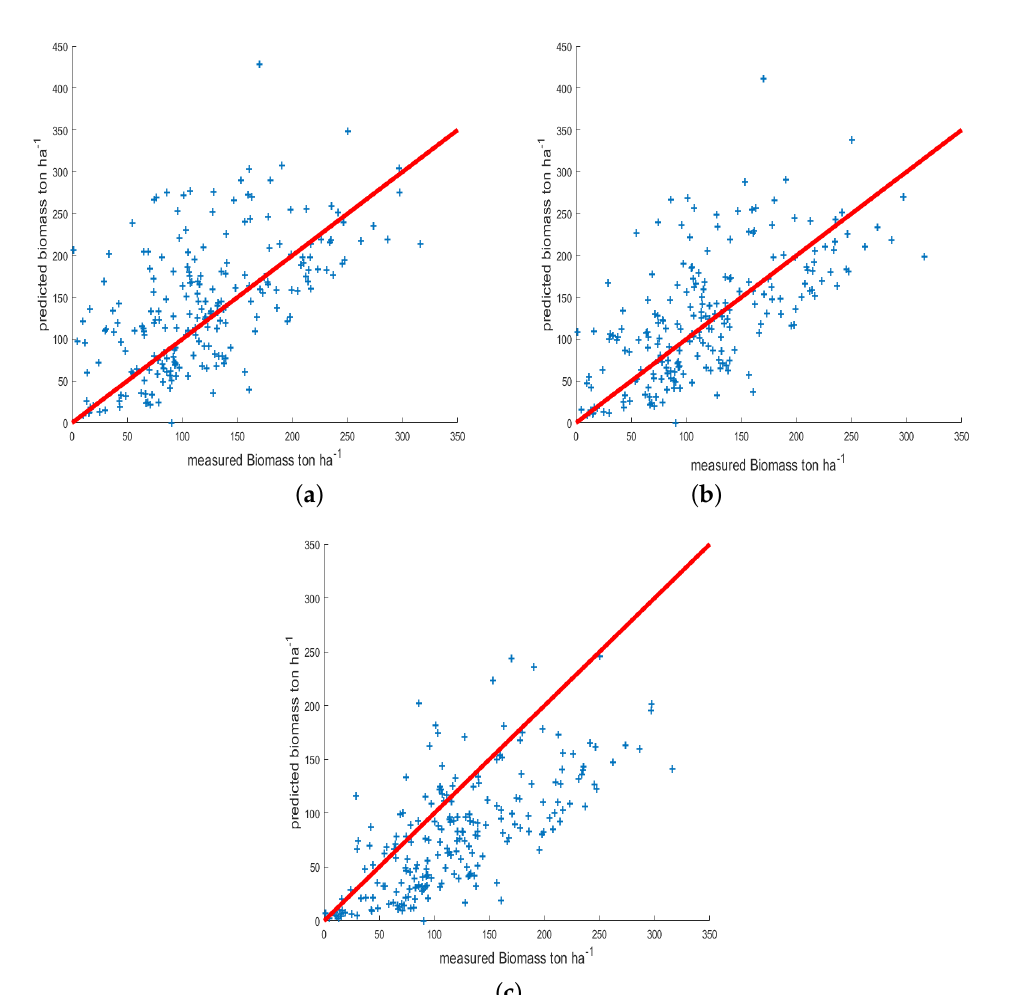
Figure 13. Relation between predicted biomass by PolInSAR data and measured biomass in field data: ( a ) the RVoG model with R 2 = 0.55 and RMSE = 30.97 (ton ha − 1 ), ( b ) the RMoG model with R 2 = 0.69 and RMSE = 30.76 (ton ha − 1 ), and ( c ) the RMoG L model with R 2 = 0.74 and RMSE = 30.69 (ton ha − 1 ). Red line is 1:1